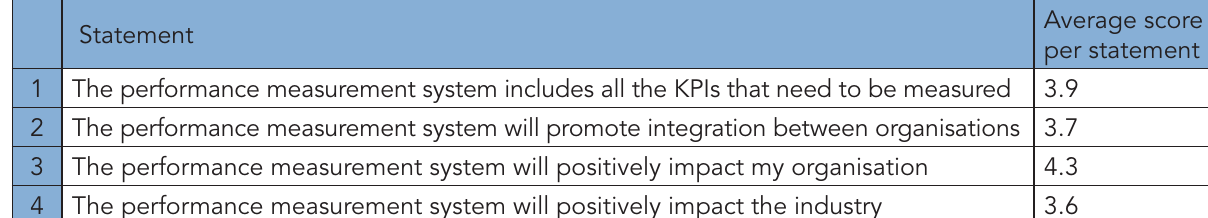
Table 2: Survey results – average score per